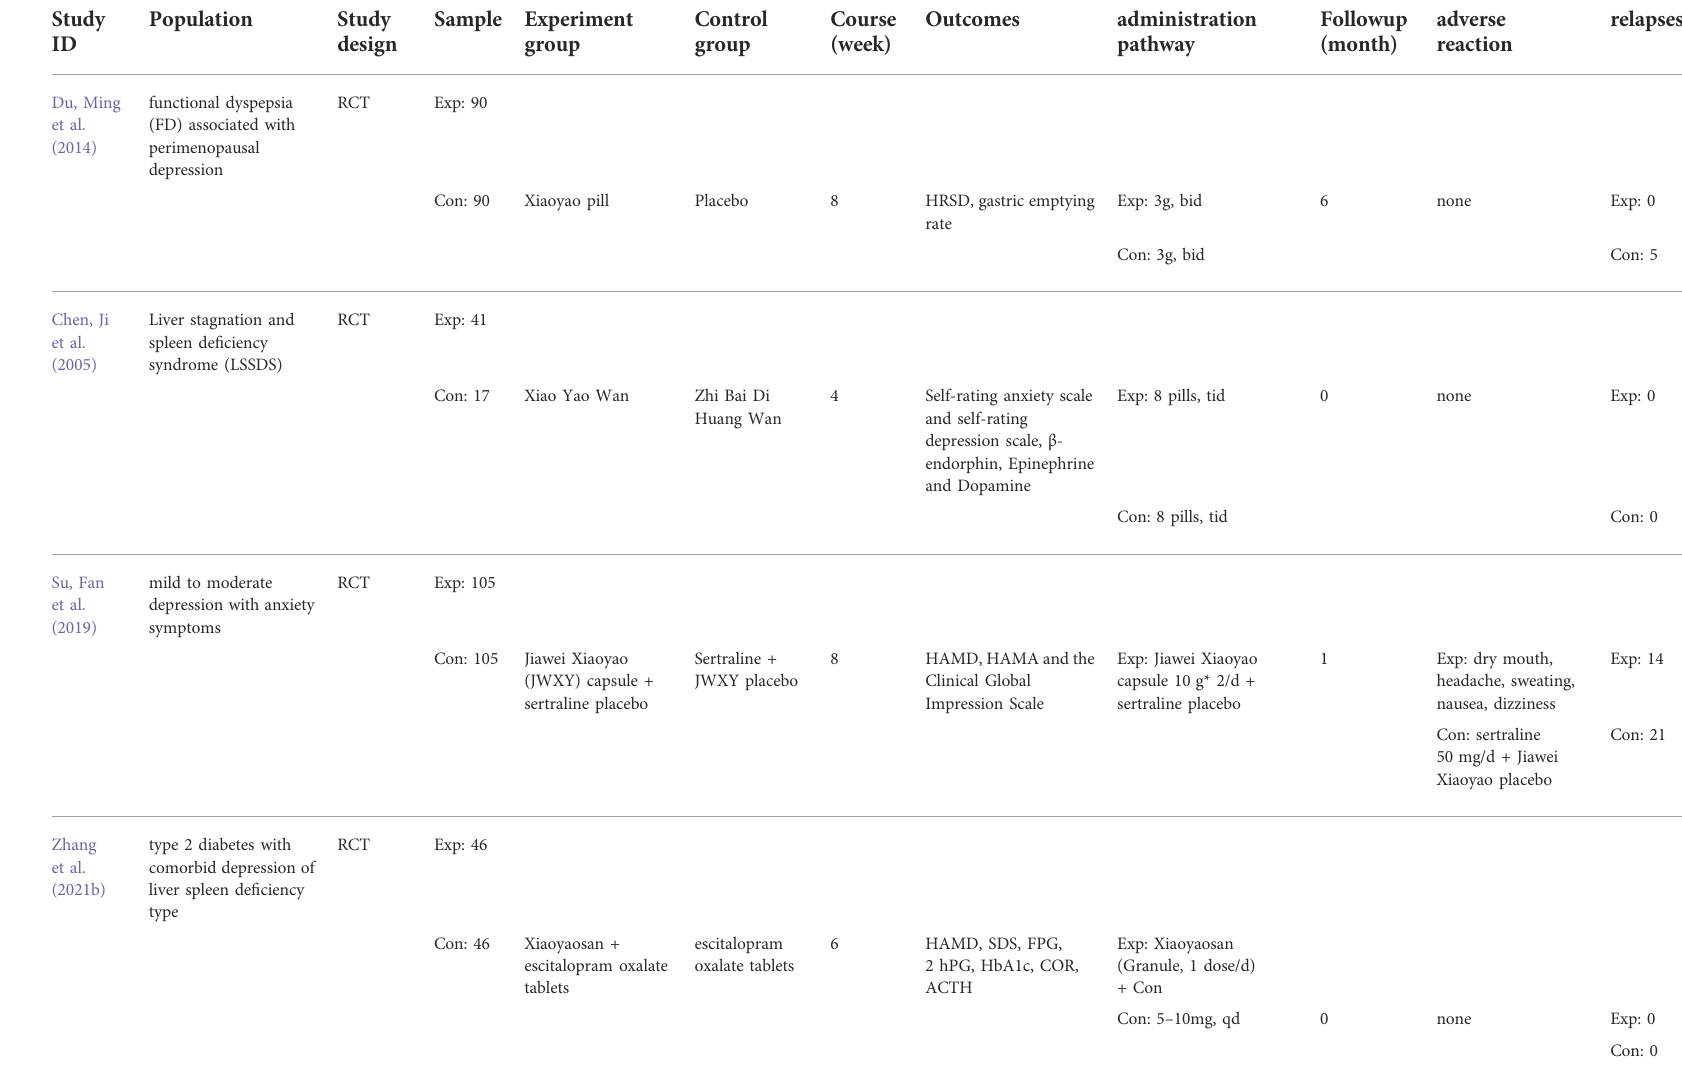
TABLE 2 The clinical application of XYS in the treatment of depression. Characteristics of study Study